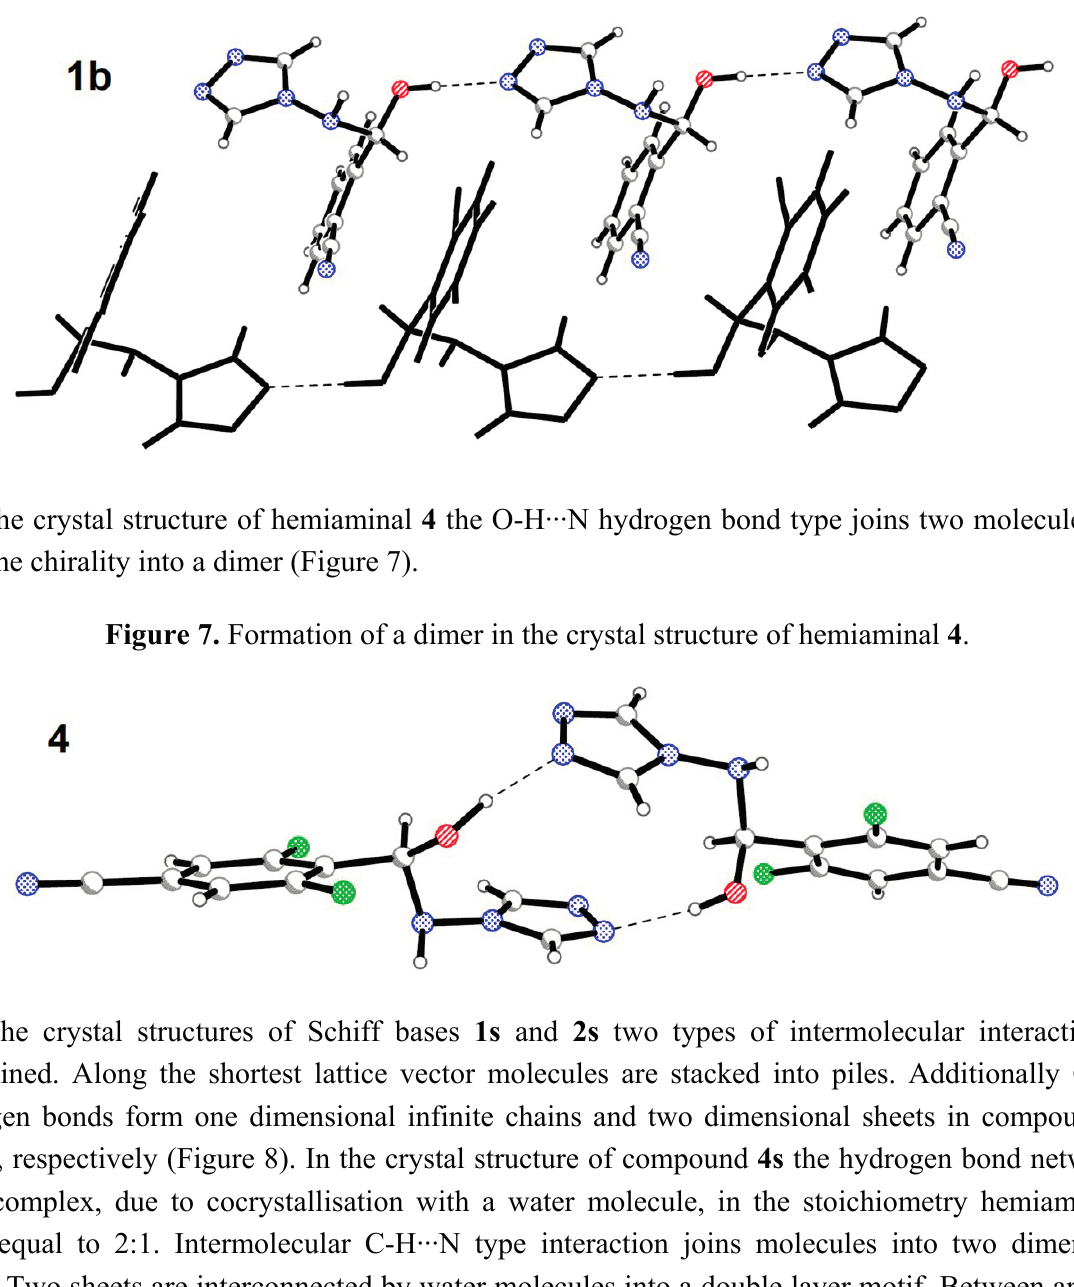
Figure 6. Single column zipper-like motif in the crystal structure of twisted hemiaminal 1b.